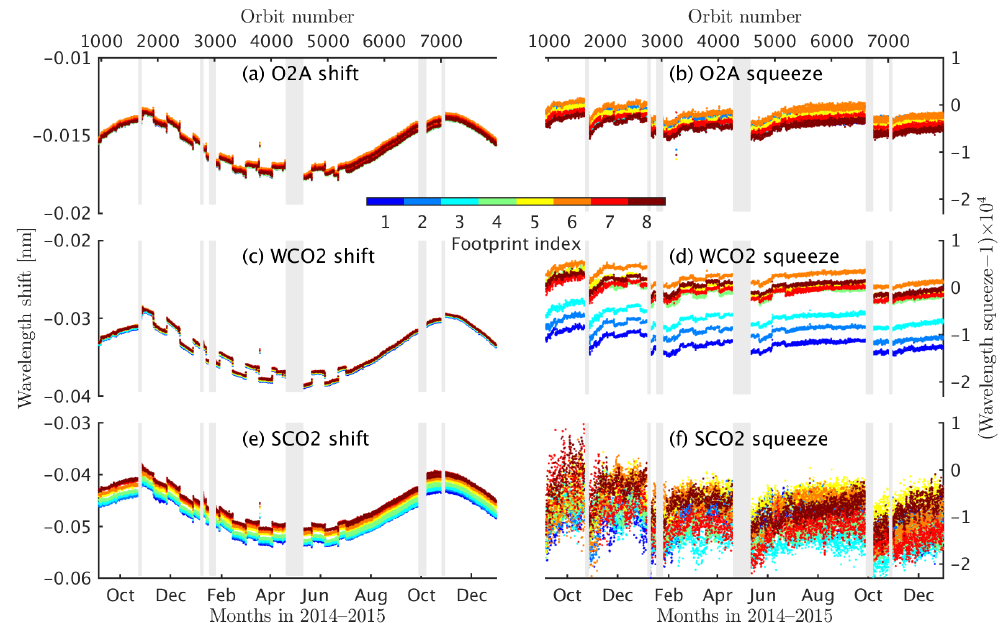
Figure 4. Temporal variation of wavelength shift and squeeze terms of the measured solar spectra for all spatial footprints of all OCO-2 bands. The stepwise features in the wavelength shift (a, c, e) are due to transitions between nadir and glint observations which lead to different instrument temperatures. The gaps of data (marked as gray bands) in all six panels are due to decon cycles. These results are derived using the stretch-only fitting. The stretch/sharpen, super Gaussian, and hybrid symmetric fits give essentially the same wavelength calibration